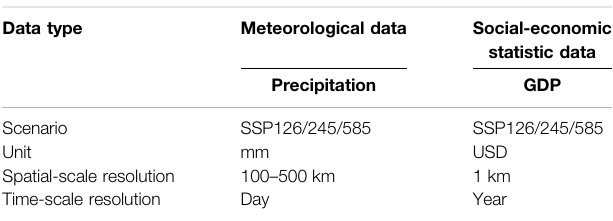
TABLE 2 | Future data.